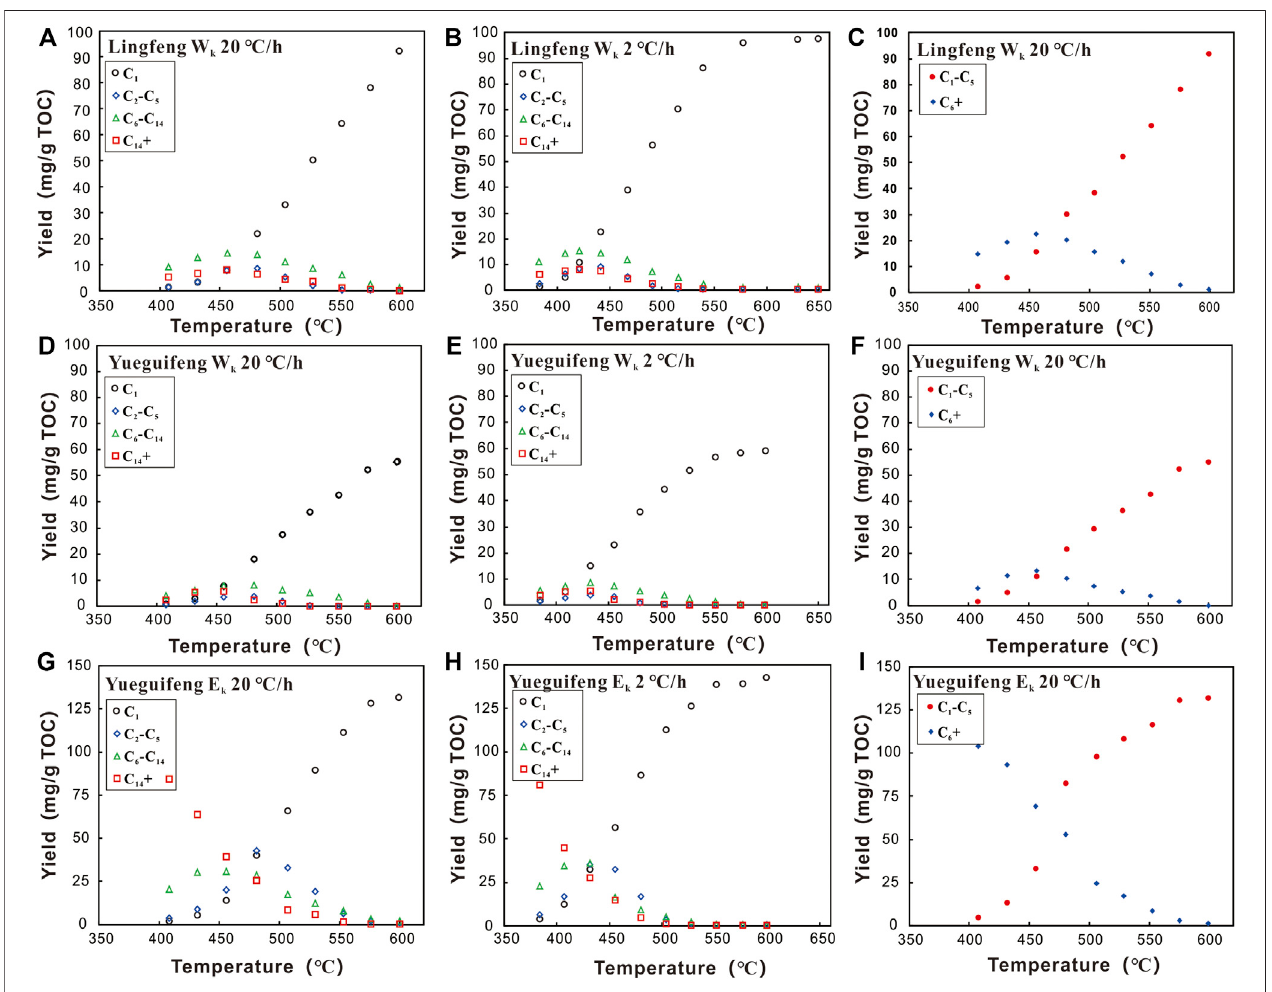
FIGURE 3 | Hydrocarbon generation characteristics of kerogen in source rocks of Lishui Sag under two heating rates.